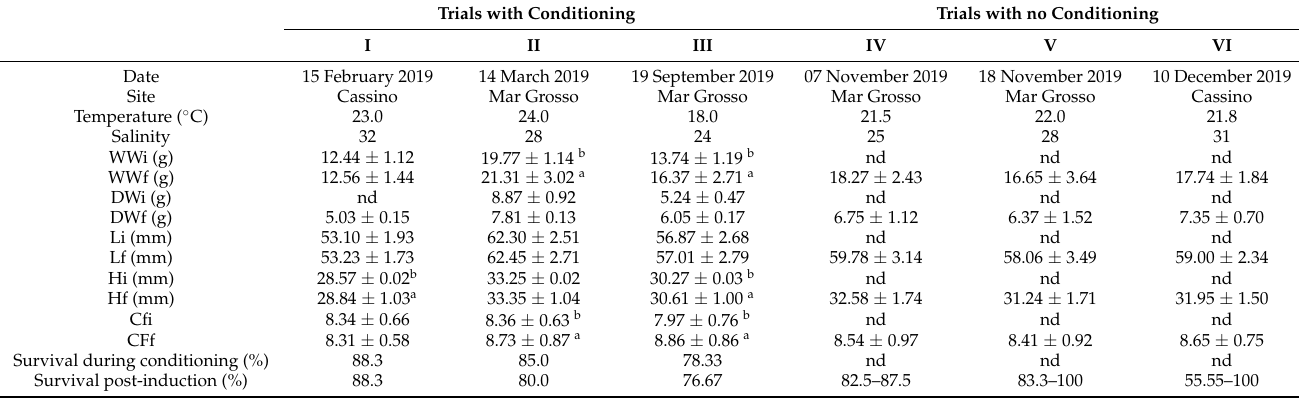
Table 1. Date, site, temperature, and salinity during field collection, and means ( ± SD) of initial and final wet weight (WWi and WWf, respectively), dry weight (DW), total length (L), height (H), condition factor (CF), and survival rates of yellow clam ( Amarilladesma mactroides) collected at the beaches of Cassino and Mar Grosso, southern Brazil, for trials with a 14-day conditioning period (Trials I, II, and III) and no conditioning period (Trials IV, V, and VI). Superscripts indicate significant differences between initial and final parameters within the same trial. Parameters that were not measured are referred to as nd (=not